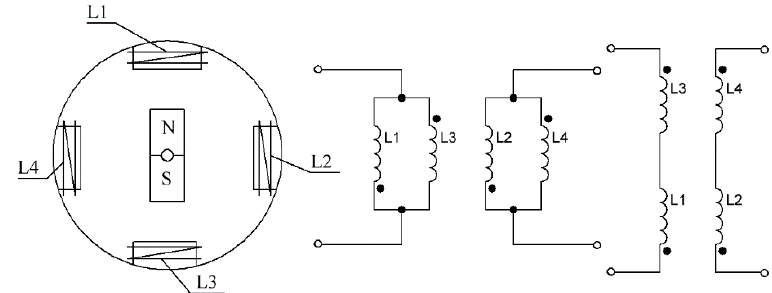
Figure 3. Two-phase generator.